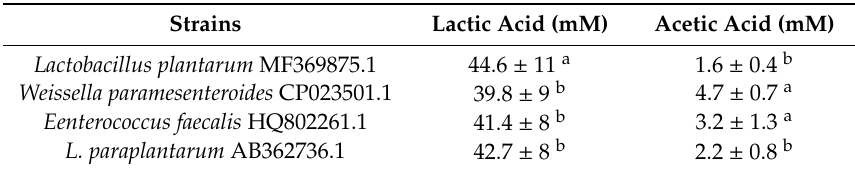
Table 1. Concentrations (mM) of organic lactic and acetic acids after growth (48 h at 37 ◦ C) of selected Lactobacillus strains.